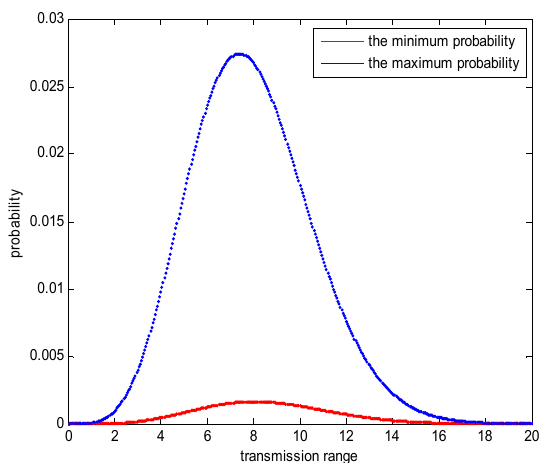
Figure 26. The probability that the network cannot meet the requirements of interference ‐ optimality and energy ‐ efficiency.